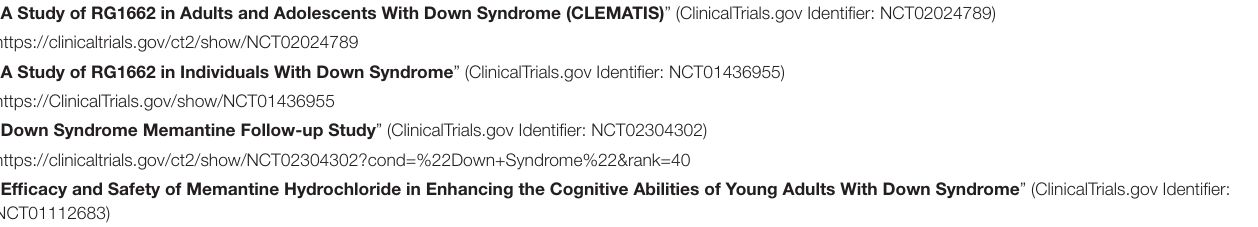
TABLE 3 | Clinical trials for intellectual disability in individuals with Down syndrome. “ A Study of RG1662 in Adults and Adolescents With Down Syndrome (CLEMATIS) ” (ClinicalTrials.gov Identifier: